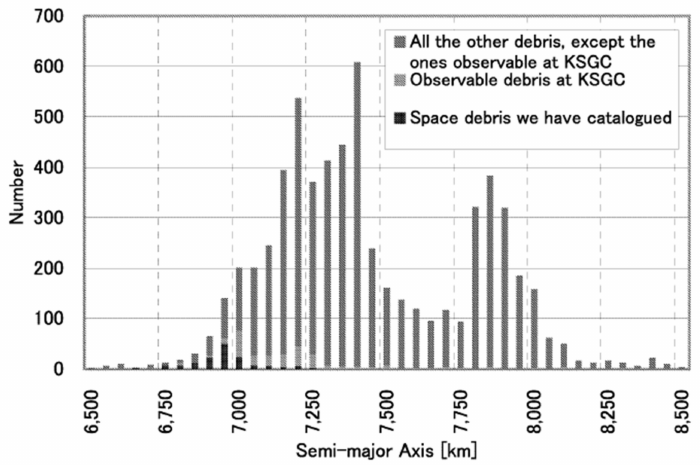
Figure 23. Number of pieces of debris detected and catalogued vs. orbit semimajor axis for the Kamisaibara Space Guard Center (KSGC) radar 2014 campaign [62]. Reprinted from 4th European Conference on Space Debris (ECSD), Copyright 2005, with permission from